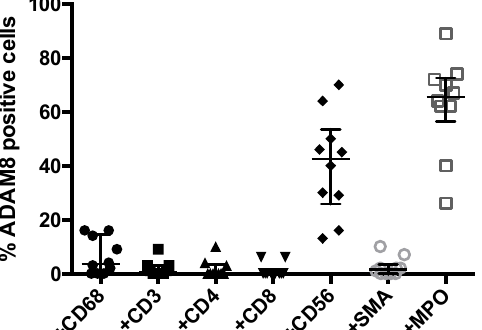
Figure 3. Scatter dot plot of the percentage of double-positive ADAM8/marker cells as analyzed in 10 representative PDAC sections stained for CD68 (•), CD3 ( ■ ), CD4 ( ▲ ), CD8 ( ▼ ), CD56 ( ♦ ), SMA ( ○ ) and MPO ( □ ). Note that the frequency of ADAM8 + stromal cells is highest for macrophages (CD68), NK cells (CD56), and neutrophils (MPO). For each section analyzed, data are derived from quantification of 5 viewing fields in the tumor proximal stroma areas. Median values with interquartile ranges are indicated. Note that the highest frequency of co-localization of ADAM8 with stromal markers is observed for MPO (neutrophils).